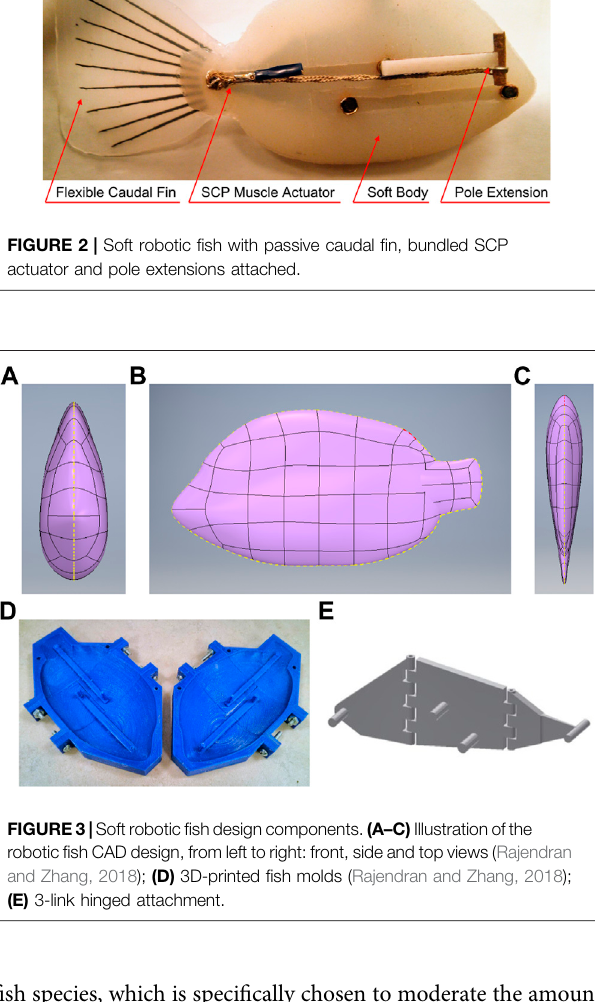
Frontiers in Robotics and AI |